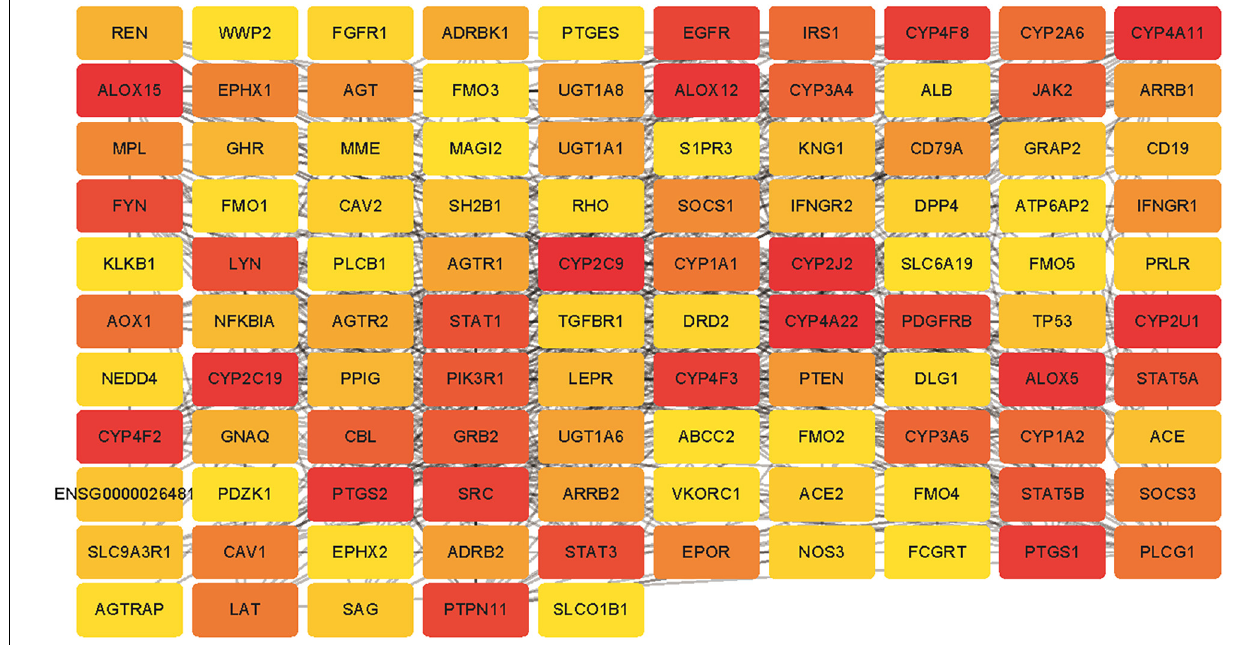
FIGURE 3 | The PPI network for the DPTs and indirect protein targets (IPTs) of SV was constructed using STRING and no more than 50 interactors on the first and second shell were set as the cut-off criteria with the highest confidence (score = 0.9). The IPTs and DPTs were visualized by Cytoscape (v.3.8.2). The red to yellow rectangles represent scores from high to